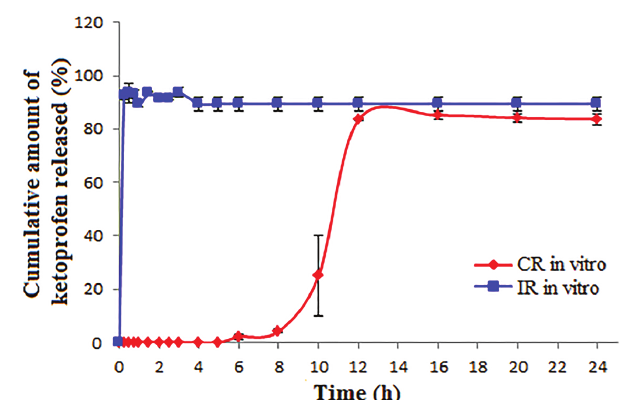
FIGURE 2 – Ketopofen release from IR-tablets (n=3) – in phosphate buffer (pH 6.8) for 24 h – and CR-tablets (n=3), in HCl (pH 1.2) for 2 h, followed by phosphate buffer (pH 6.8) for